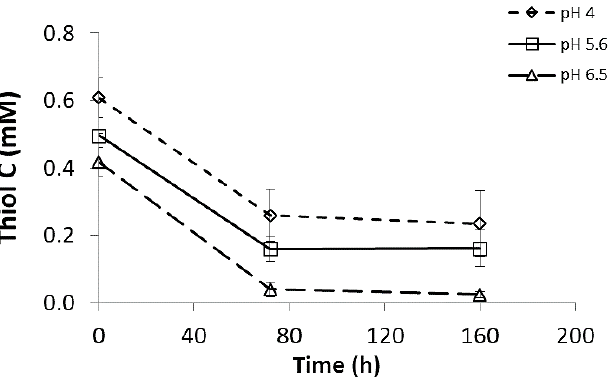
Figure 4. Kinetic analysis was performed using Ellman’s reagent representing the thiol concentra- tion in gel vs. time. The bars represent the standard error of the mean, n = 3.